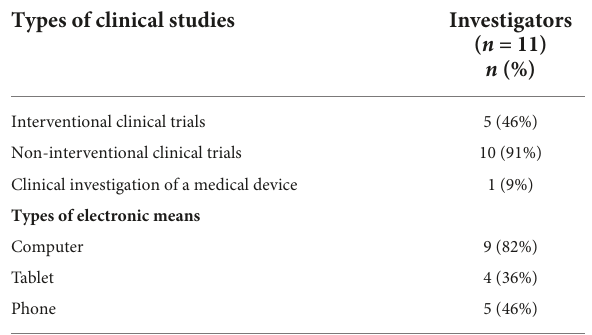
TABLE 3 Experience of investigators with